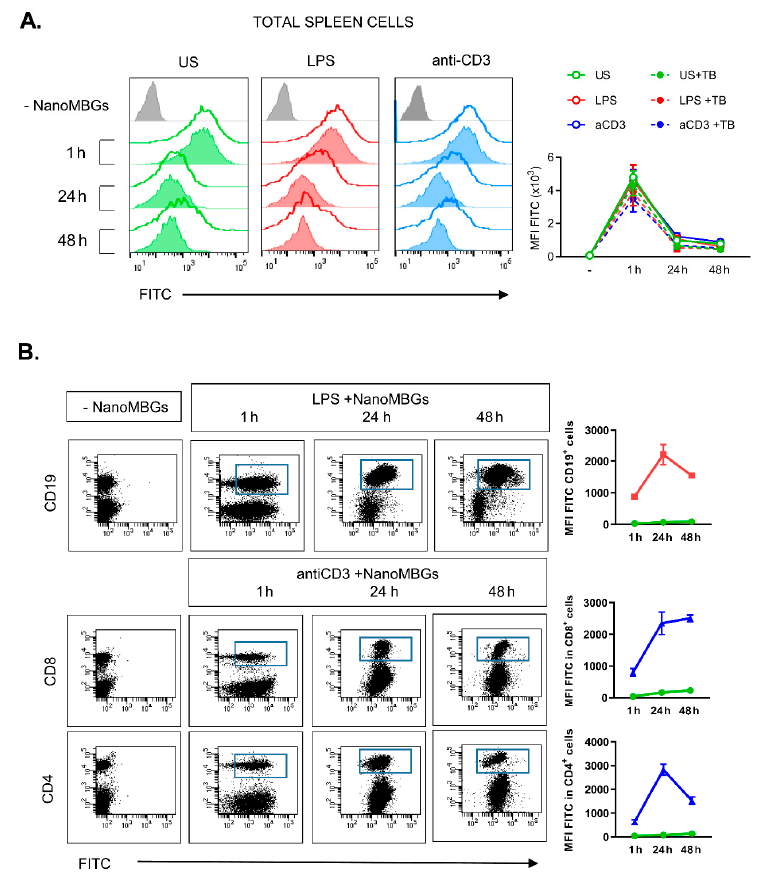
Figure 1. Incorporation of mesoporous bioactive glass nanospheres (NanoMBGs) by murine spleen cells. ( A ) Representative histograms showing the incorporation of NanoMBGs labeled with